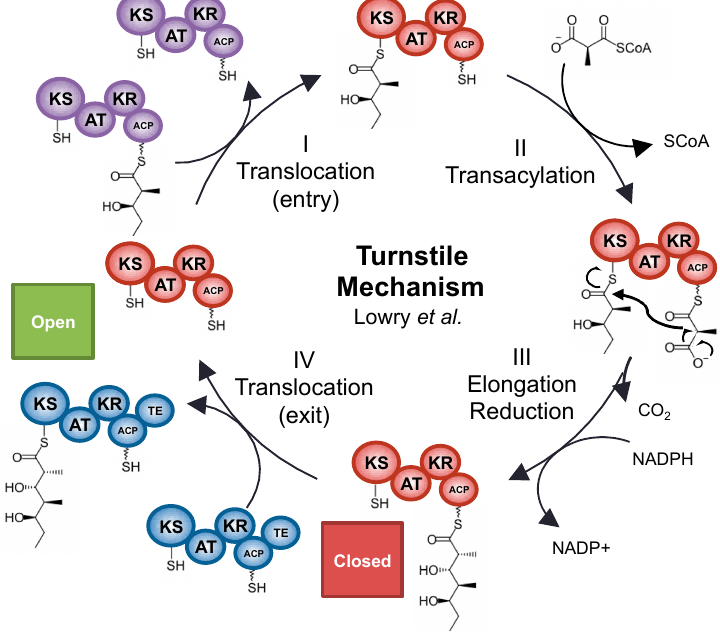
Figure 4. Operation of the turnstile mechanism during a catalytic cycle of an mPKS module. Step I: The KS of a module receives a diketide from the upstream module’s ACP. Step II: a methylmalonyl extender unit is attached onto the current module’s ACP. Step III: the ACP brings the elongation unit to the KS, which catalyzes elongation. The ACP then removes the new triketide, and shuttles it to other reducing domains. Although the KS is empty, it cannot accept another chain until Step IV: when the ACP of the current module translocates the acyl chain to the next KS.